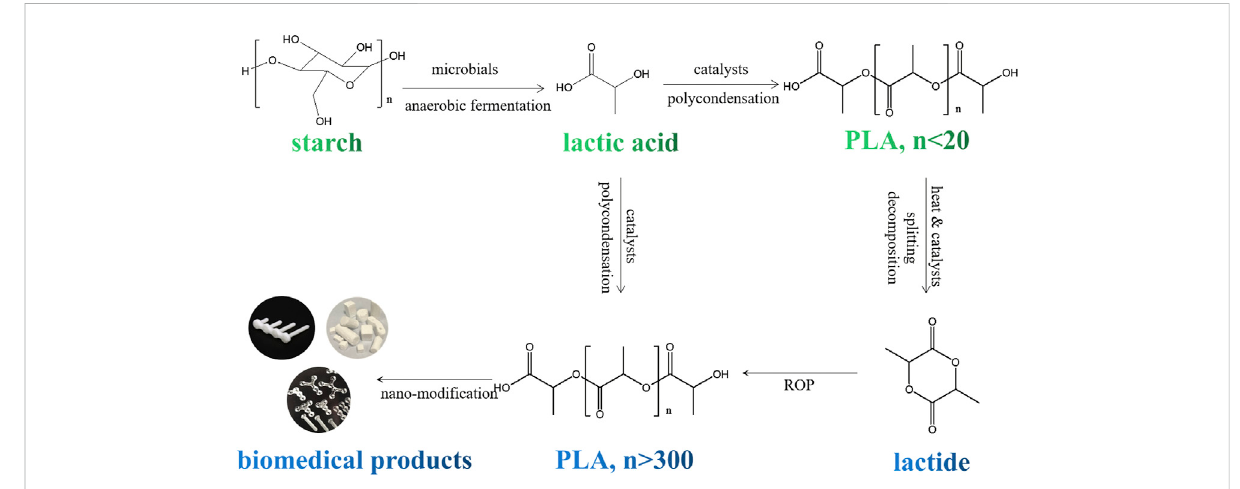
FIGURE 7 Schematic illstration for preparation process of PLA based biomedical products from renewable raw